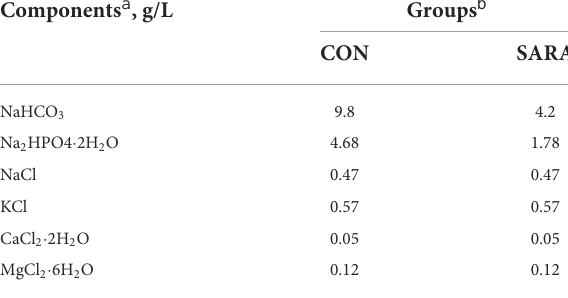
TABLE 1 Ingredients and chemical composition of the experimental diet for goats.